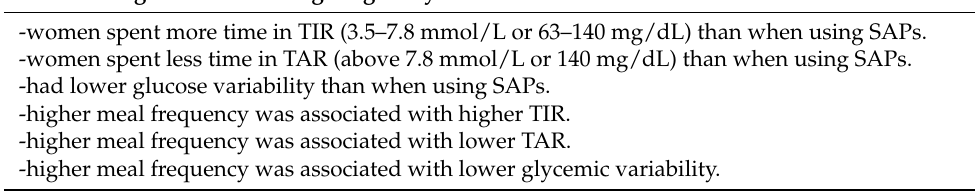
Table 4. Summary of